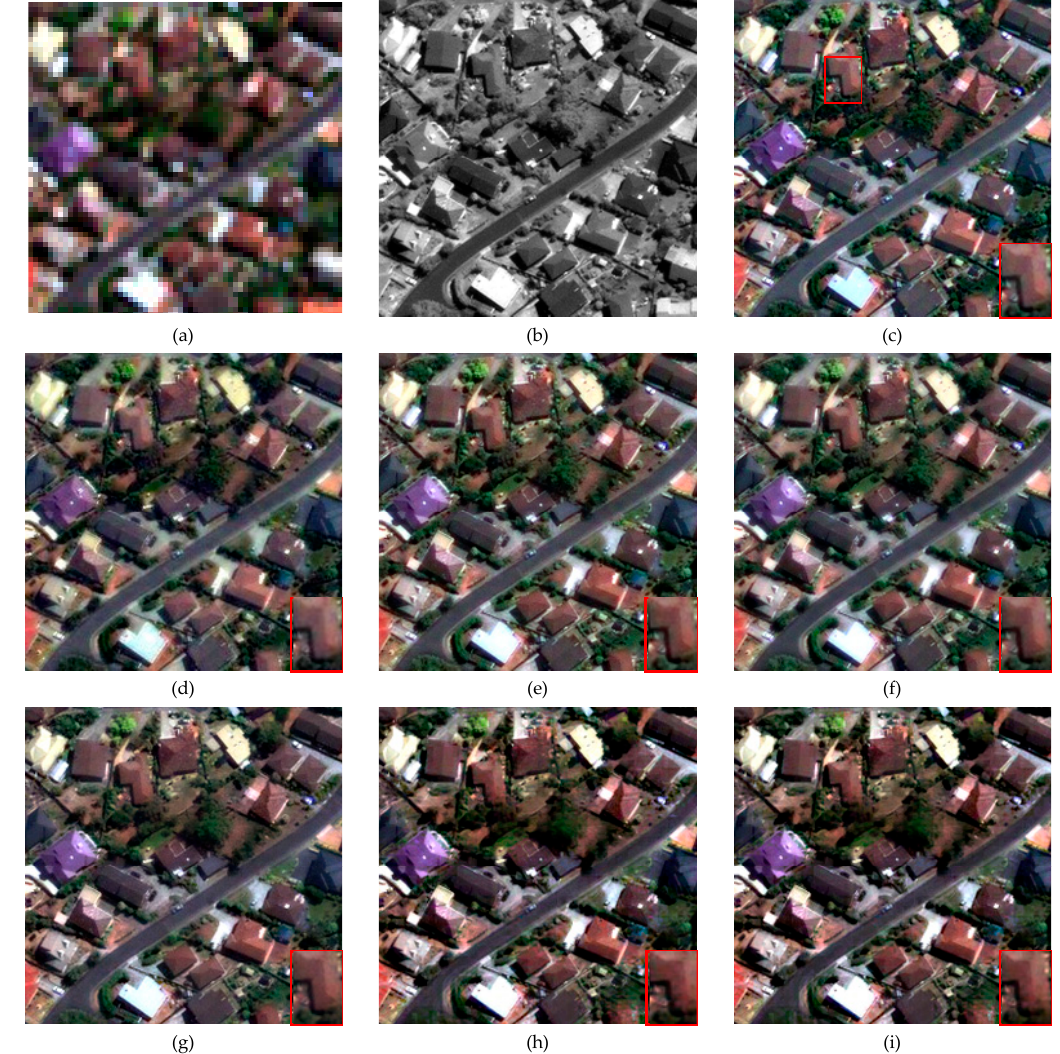
Figure 12. Fusion results of full-scale Geoeye-1 images. ( a ) LR MS image, ( b ) PAN image, ( c ) GIHS [49], ( d ) PCA [6], ( e ) AWLP [50], ( f ) SVT [12], ( g ) SparseFI [32], ( h ) NE, ( i ) SWNE.